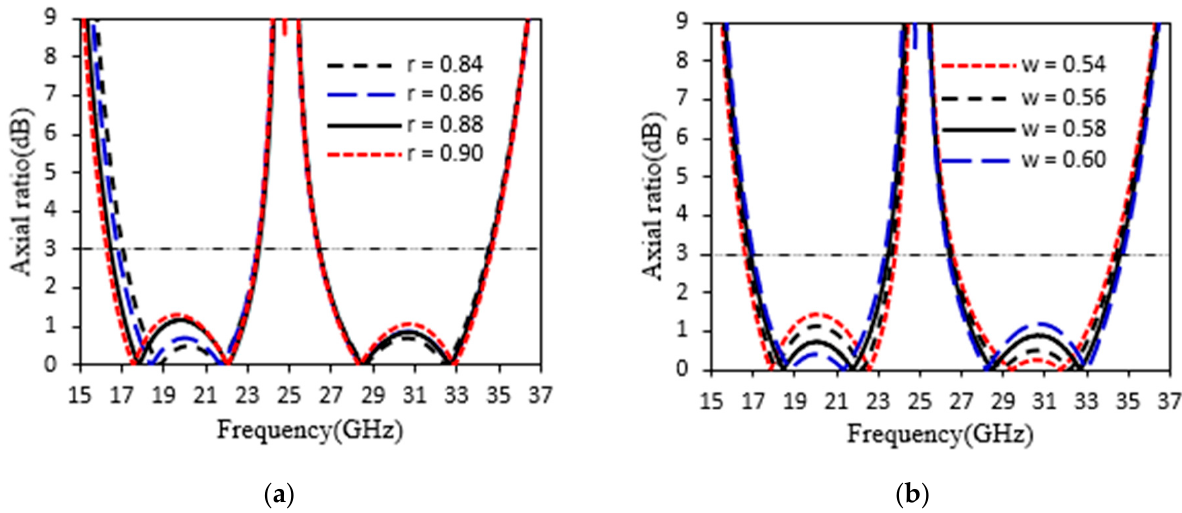
Figure 6. The simulated parametric results of axial ratio (dB) at y -polarized incidence. ( a ) r (0.84 mm to 0.90 mm) and ( b ) w (0.54 mm to 0.60